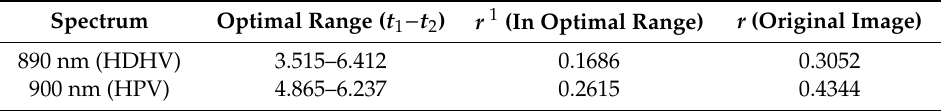
Table 2. r values of single spectrum in optimal acutance